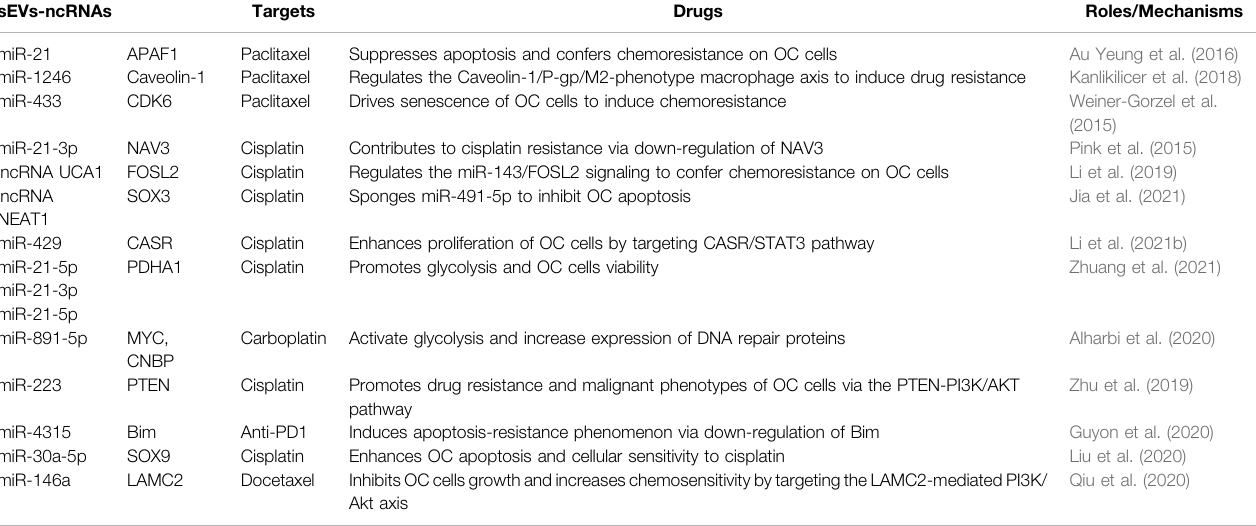
TABLE 2 | Summary of sEVs-ncRNAs involved in OC